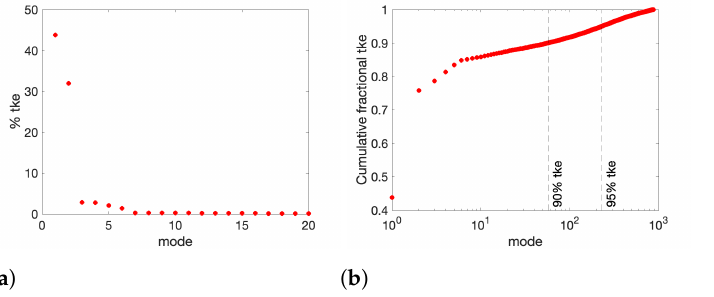
Figure 6. Initial branch U ∗ = 3.0. ( a )Energy of the first 20 POD modes expressed as a percentage of the turbulent kinetic energy ( tke ), ( b ) cumulative